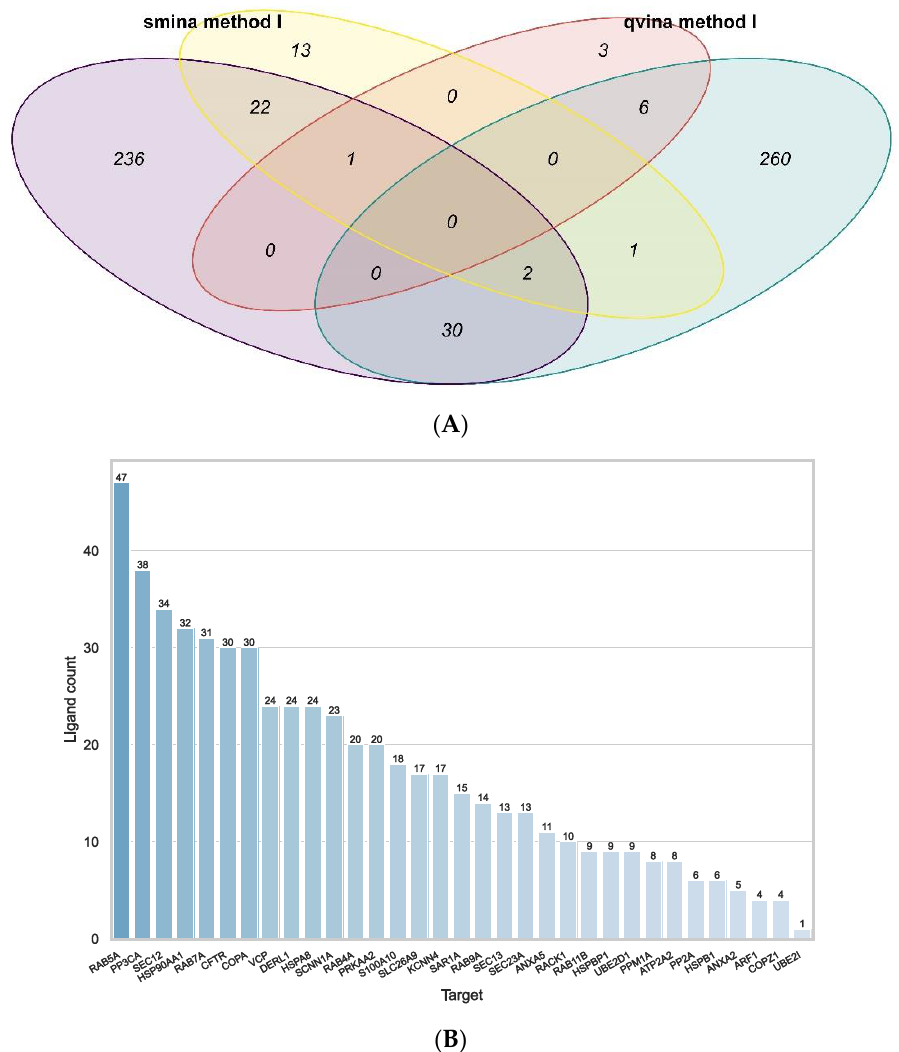
Figure 3. Results of the target-based approach using excluding PRKACA and CSNK2A1. ( A ): Venn diagram representing the number of target–ligand pairings identified by both methods with both docking programs and the overlap in results. The yellow ellipse shows the pairings identified by method I using the docking results by Smina, the red ellipse shows the results of method I using qvina-w docking results. Shown in purple and teal are the pairings identified by method II using the Smina and qvina-w docking results, respectively. ( B ): The number of ligands associated with each target by all four approaches combined.